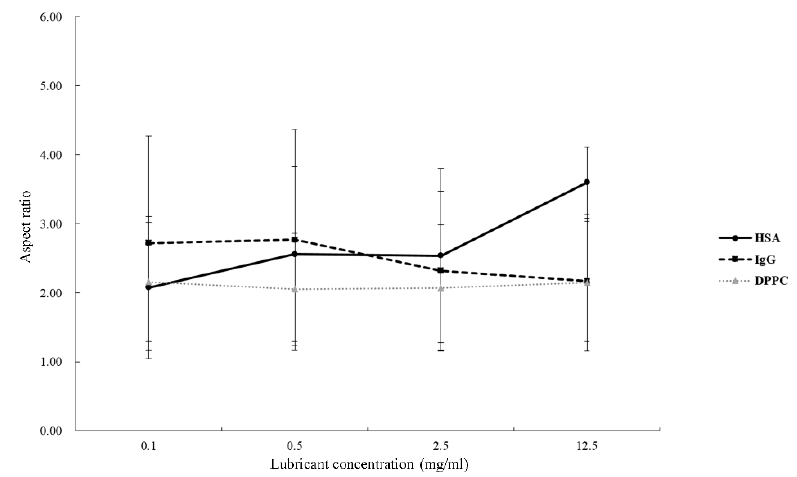
Figure 3. Aspect ratio of PEEK wear particles under the lubrication of HSA, IgG or DPPC solution. Plots of aspect ratio and the wear rate in different concentrations of HSA, IgG or DPPC solution. The wear process of the surface feature over PEEK results in a resisting force F r on PEEK (Figure 4). The vertical direction of this resisting force F rz pushes up the PEEK while lateral movement